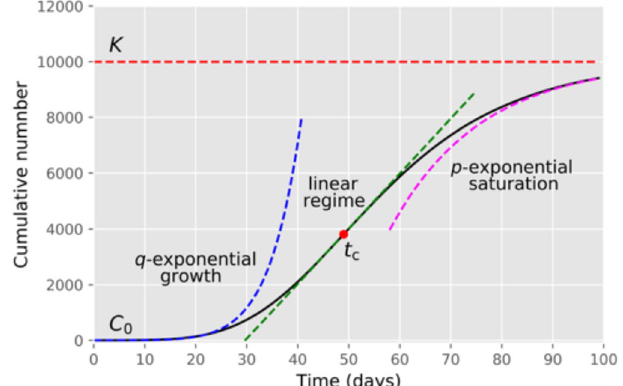
Figure 1. Schematic of a typical epidemic curve for the cumulative number of cases or deaths, where the three main regimes of growth are indicated: (i) early q -exponential growth; (ii) intermediate region of linear growth; and (iii) p -exponential saturation towards the plateau. Here C 0 is the value at t = 0 , K is the value at the end of the epidemic (plateau), and t c denotes the inflection point of the